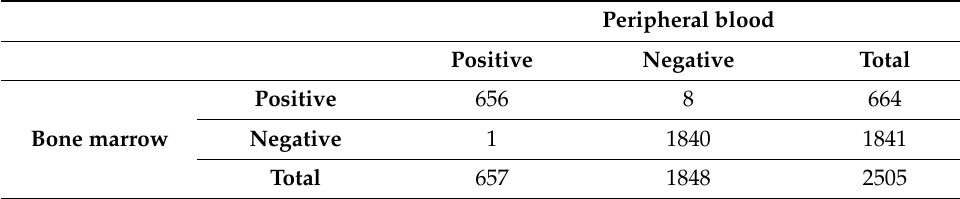
Table 3. NGS sensitivity and